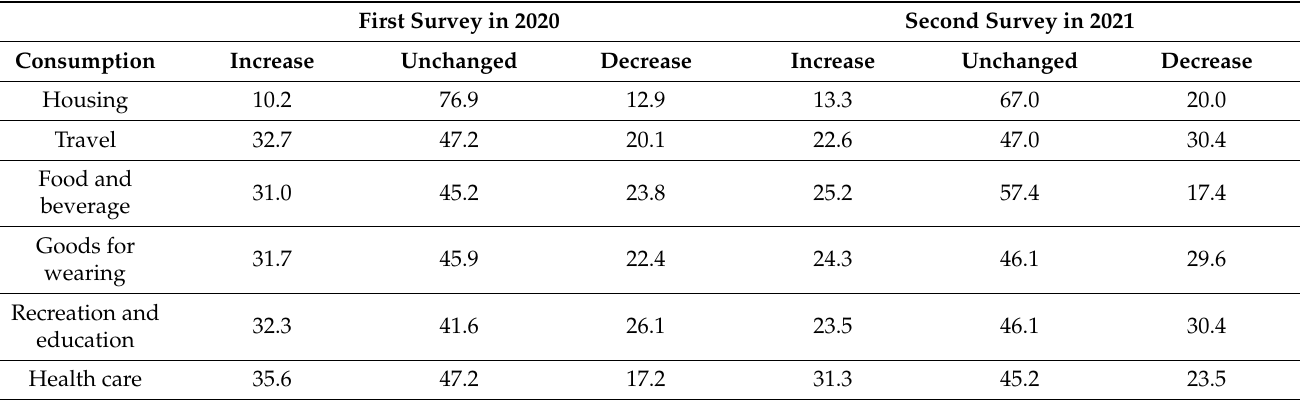
Table 4. Expected change of consumption expenditure after the